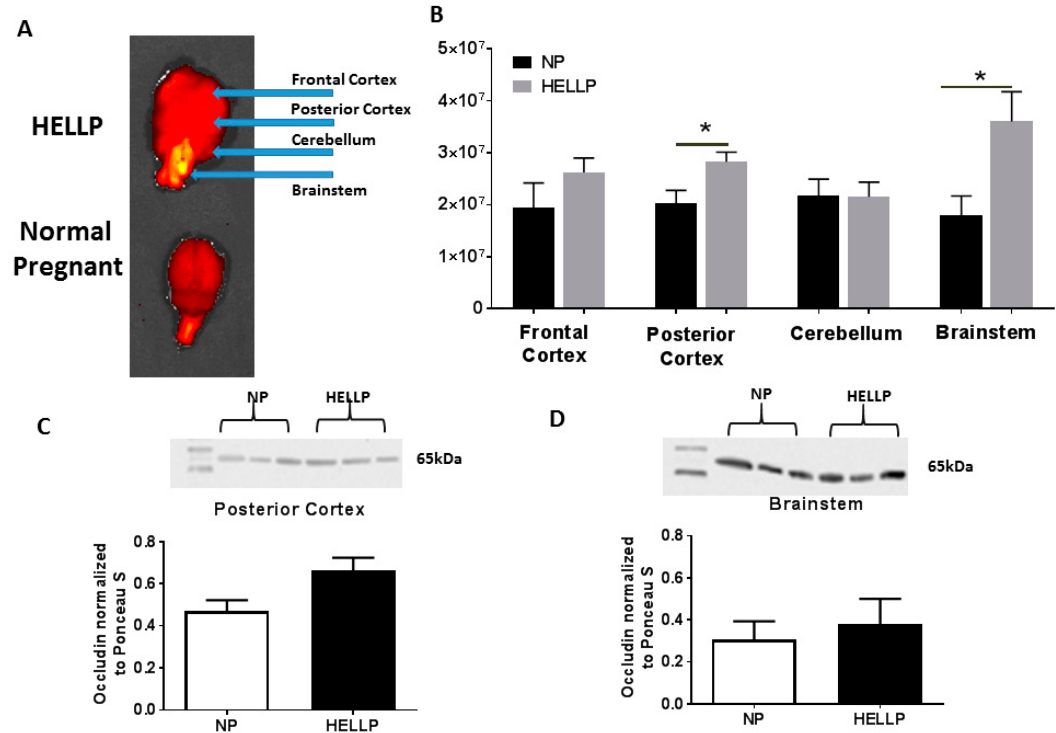
Figure 3. A representative NP and HELLP brain from rats infused with 0.5 mg/mL of Texas Red and phenylephrine to detect blood brain barrier (BBB) structural integrity ( A ). The blue arrows indicate the regions of interest that were analyzed utilizing In Vivo Imaging System (IVIS). HELLP rats had significantly more Texas Red in the posterior cortex and in the brainstem compared to NP rats ( B ). Representative western blot of homogenates from the posterior cortex ( C ) and brainstem ( D ) depicting the characteristic band at 65 kDa for occludin, and bar graphs showing the relationship between NP and HELLP rats within each respective brain region. Data are represented as mean ± SEM; * denotes p < 0.05; NP, n = 3–5; HELLP, n = 3–6.